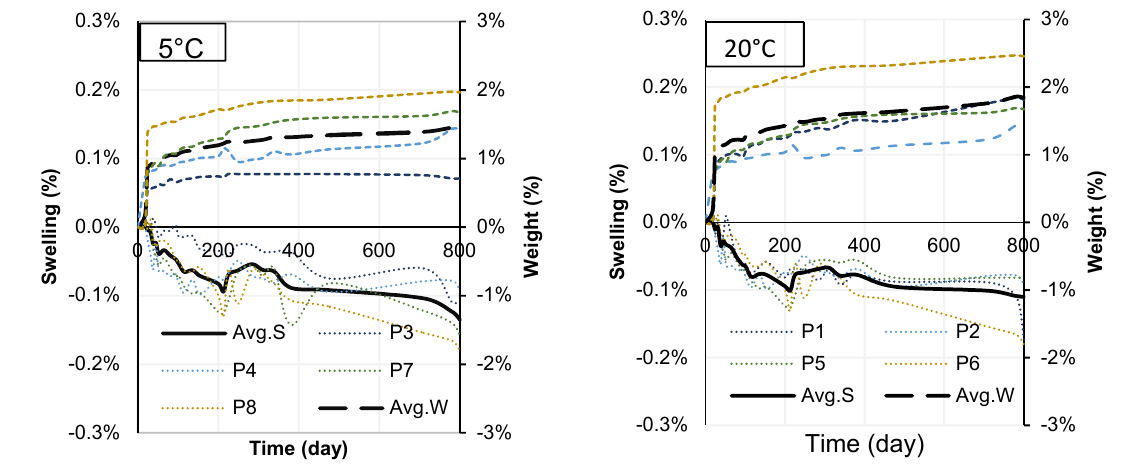
Figure A1. Swelling results in S + F + W1.